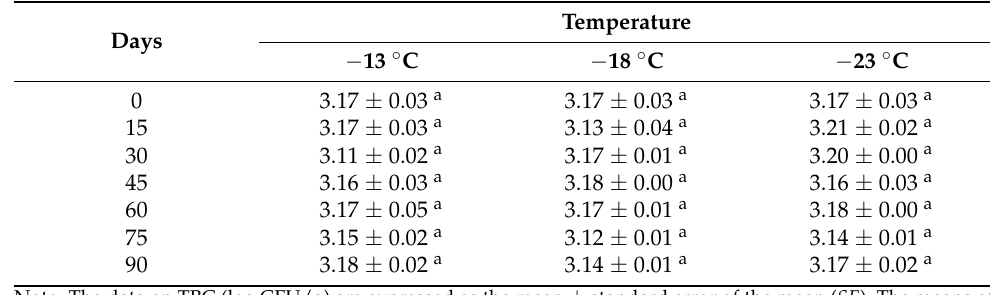
Table A1. Total bacterial count (TBC) of braised mackerel with radish during storage for 90 days at three different freezer